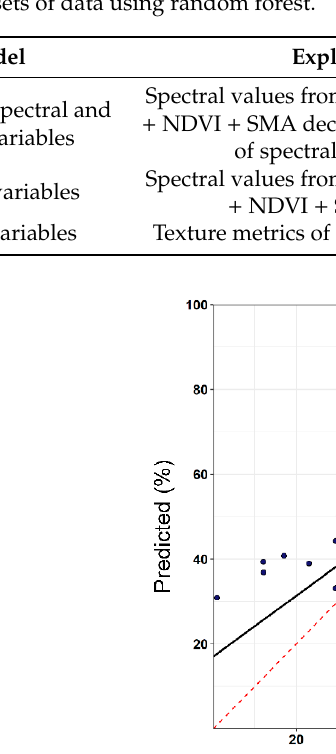
Table 2. Summary statistics of the tree species deciduousness weighed by basal area sampled at field in 1 ha forest inventory plots, measured as percentage.